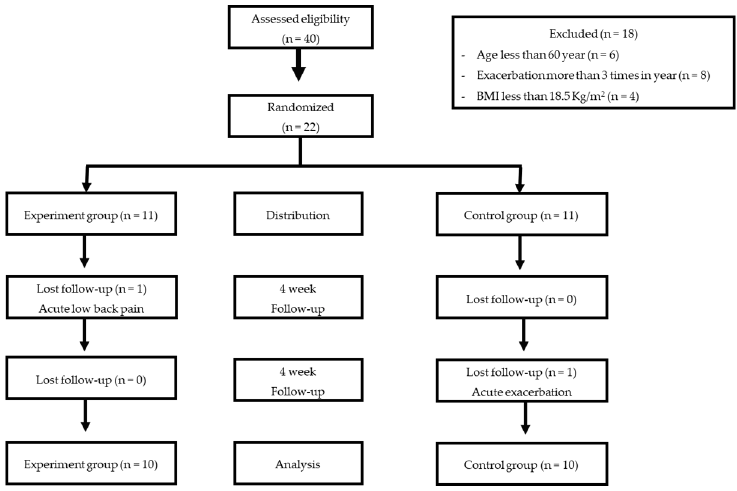
Figure 1. CONSORT flow chart of participant recruitment. Table 2. Characteristics of participants.